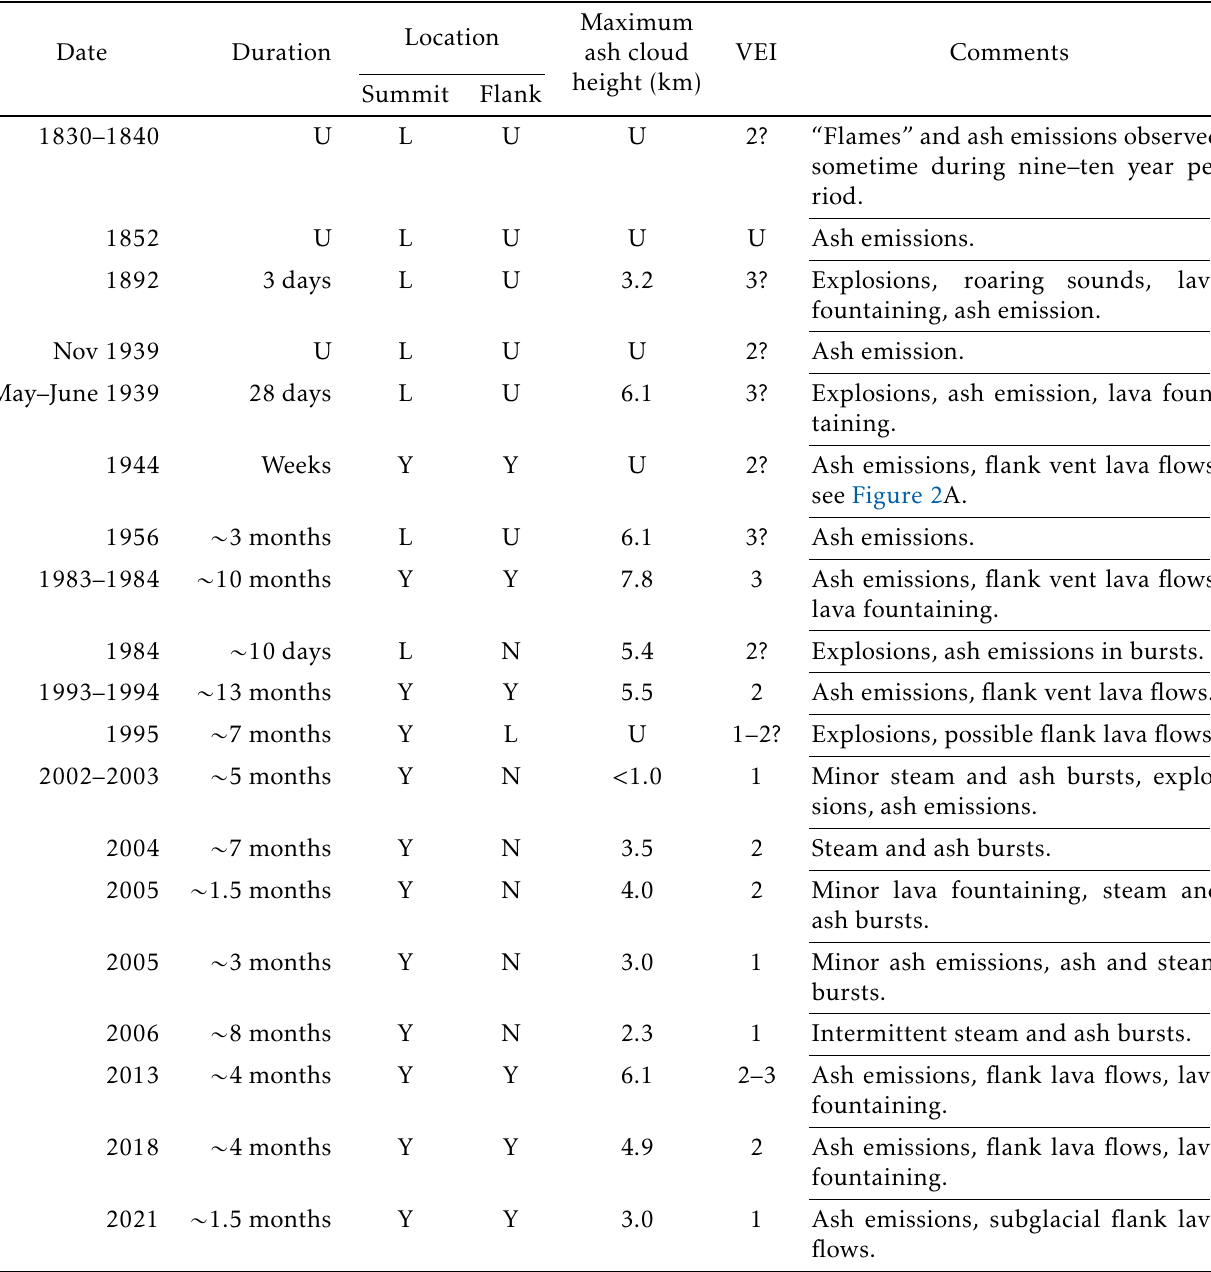
Table 1: Historical eruptions of Veniaminof volcano. U = unknown, L = likely, Y = yes, N = no. “Location” refers to the location of activity on cone A. Volcano Explosivity Index (VEI) values are estimates and in many cases not confirmed with known eruptive volumes. Data from www.avo.alaska.edu